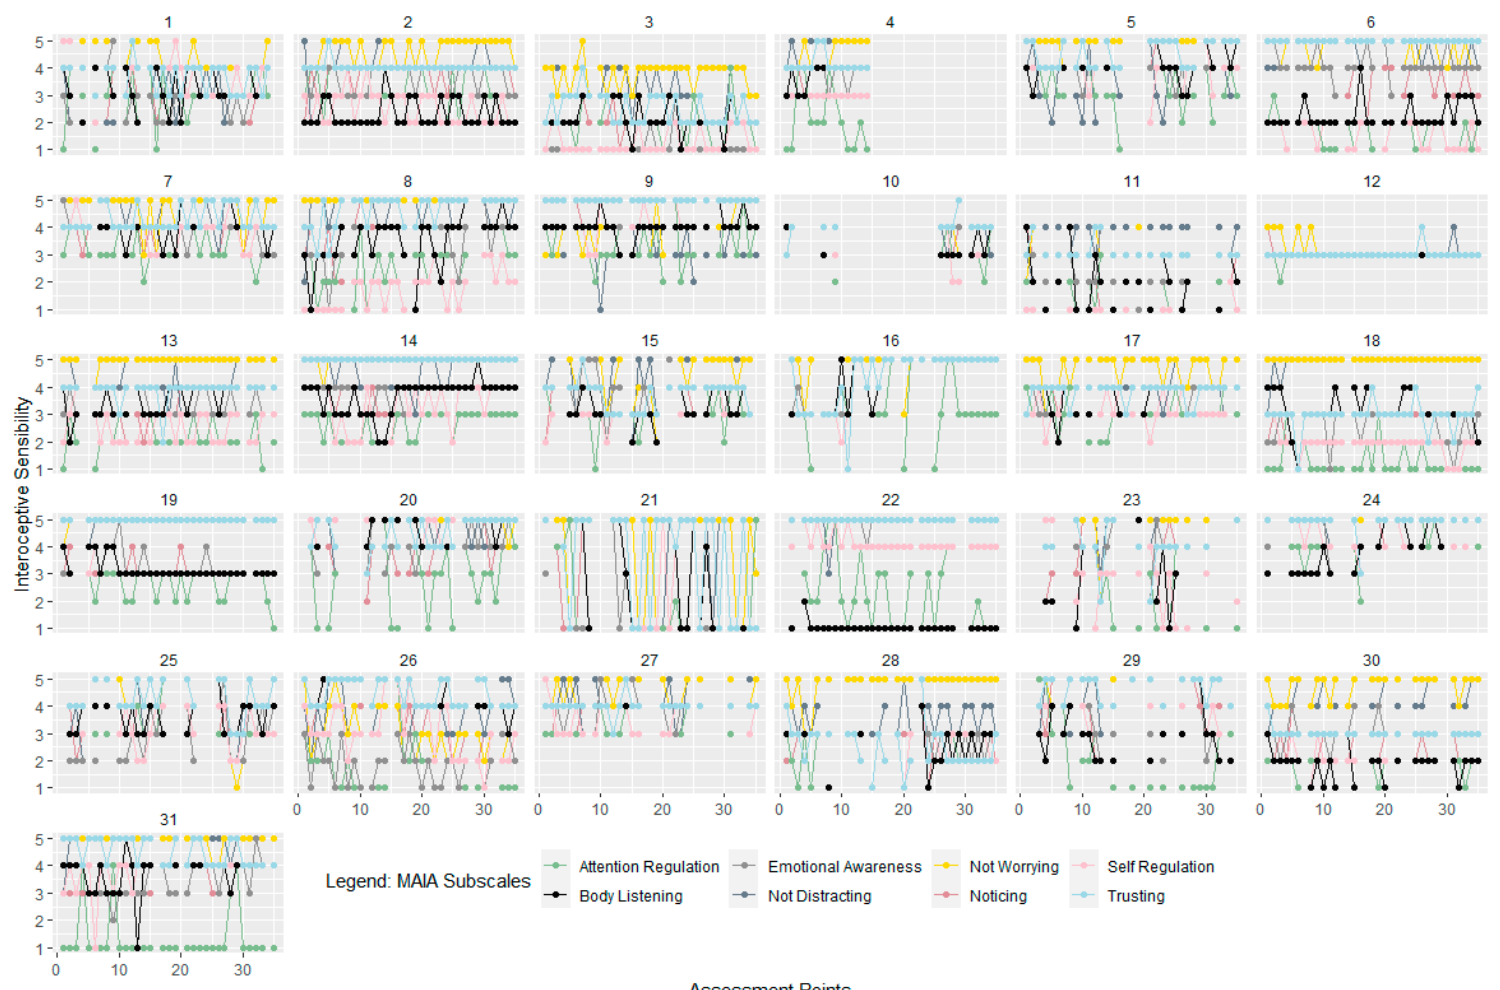
Figure 2. Interoceptive Sensibility. Trajectories of the subscales of the Multidimensional Assessment of Interoceptive Awareness for each of the 31 participants during EMA. Assessment points range from 1 to 35 over a time period of 7 days and interoceptive sensibility ranges from 1 to 5 (total score of each of the subscales).